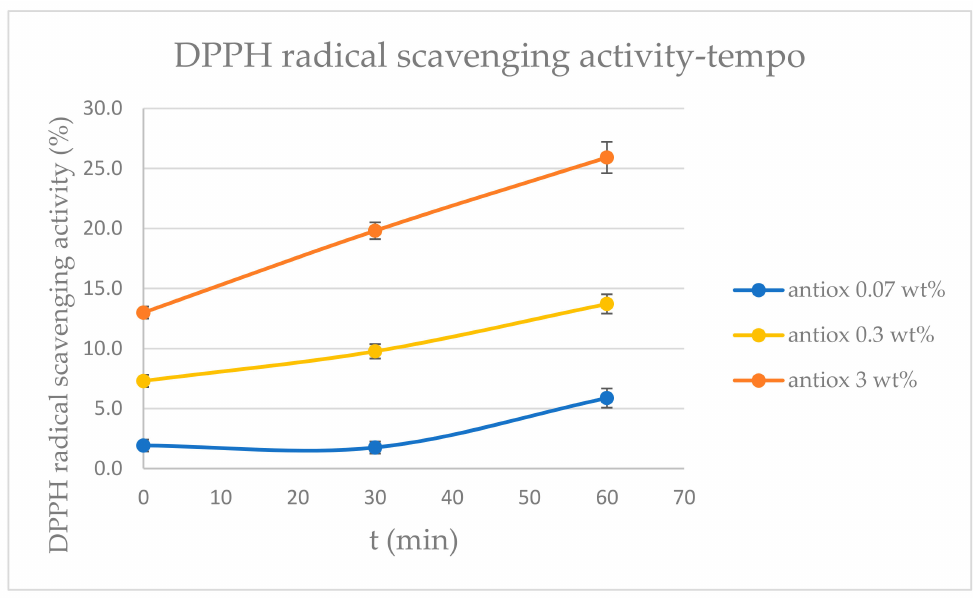
Figure 8. RSA (%) values of DPPH for polyphenol solutions at different concentrations after 0, 30, and 60